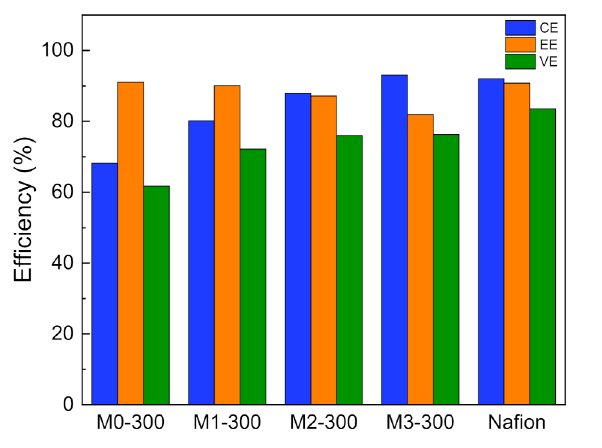
Figure 3. The performance of VFBs with Mx-300 membrane and Nafion 212 at the current density of 80 mA cm − 2 .